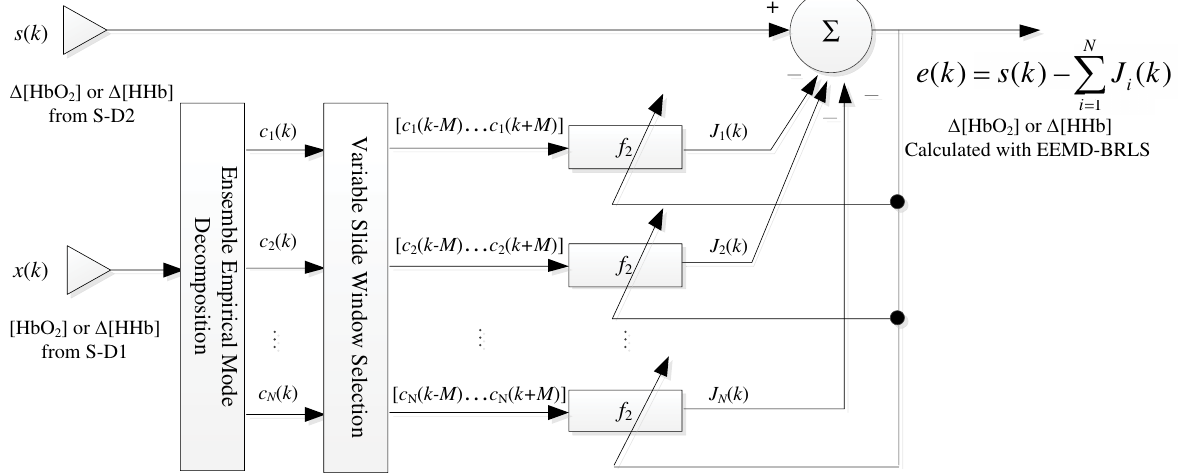
Fig. 1. Block diagram of global interference denoising using EEMD-BRLS algorithm in multi-distance fNIRS